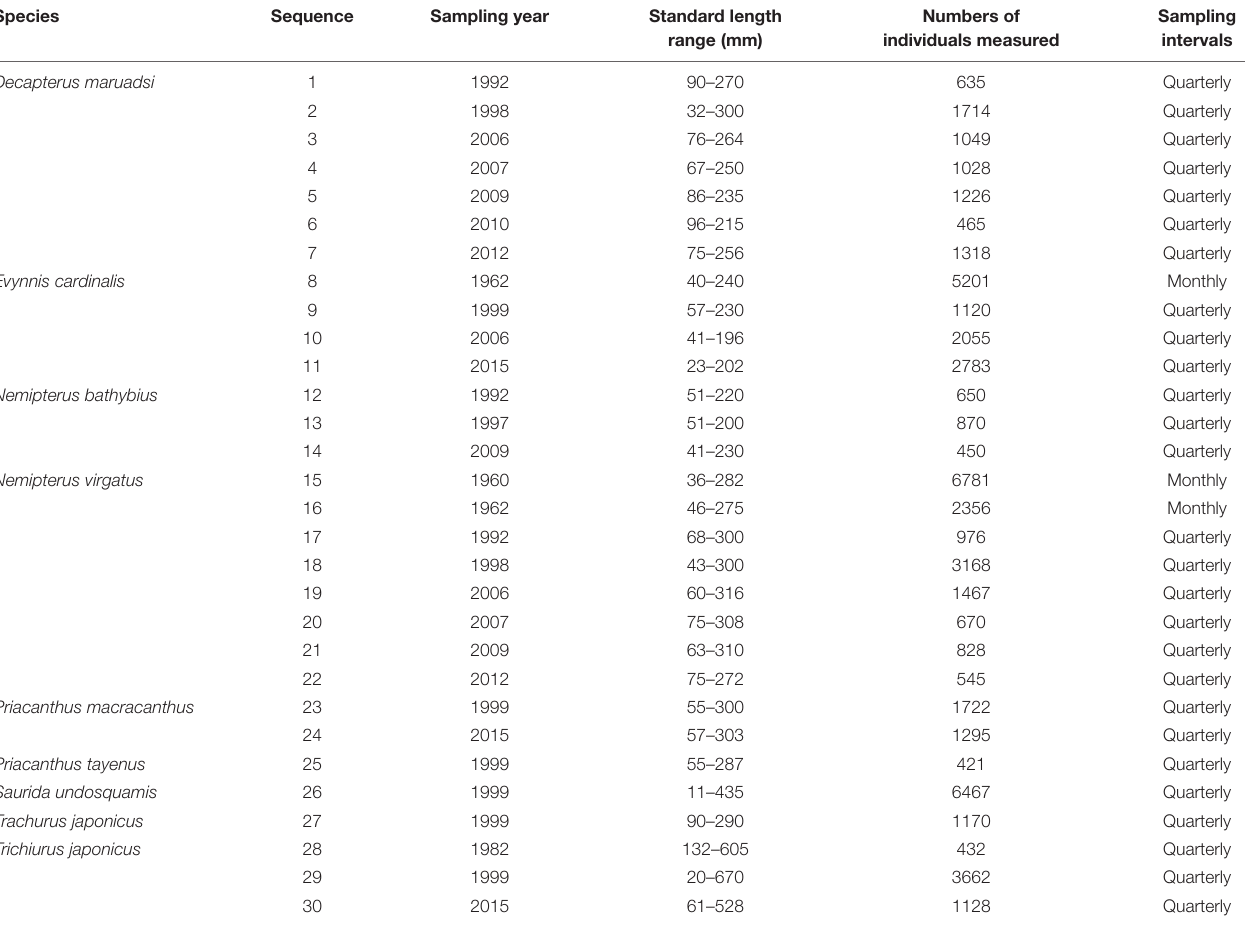
TABLE 1 | Summary of samplings and length data for nine fish stocks collected during 1962–2012 for stock assessment in Beibu Gulf, South China Sea.